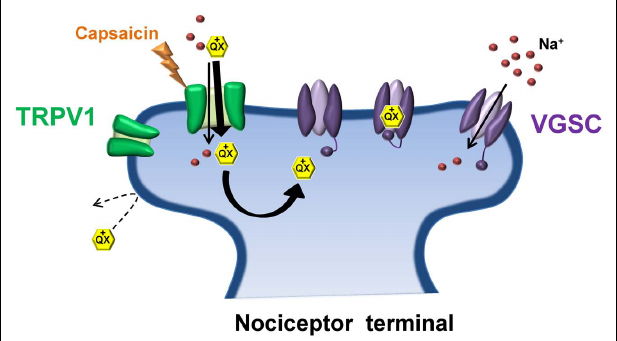
FIGURE 2 |Transient receptor potential vanilloid 1 and QX-314: No pain, no gain. Due to its positive charge, the lidocaine derivative QX-314 is unable to pass through the plasma membrane to gain access to its binding site on the intracellular face of the sodium channel pore. Activation of TRPV1 by capsaicin (the pungent ingredient in chili peppers) allows QX-314 to pass through the relatively large pore ofTRPV1, shuttling QX-314 into the cytosol where it can bind and inhibit the sodium channel.TRPV1 receptors are preferentially expressed on nociceptive terminals thus allowing selective inhibition of pain-transmitting nerve